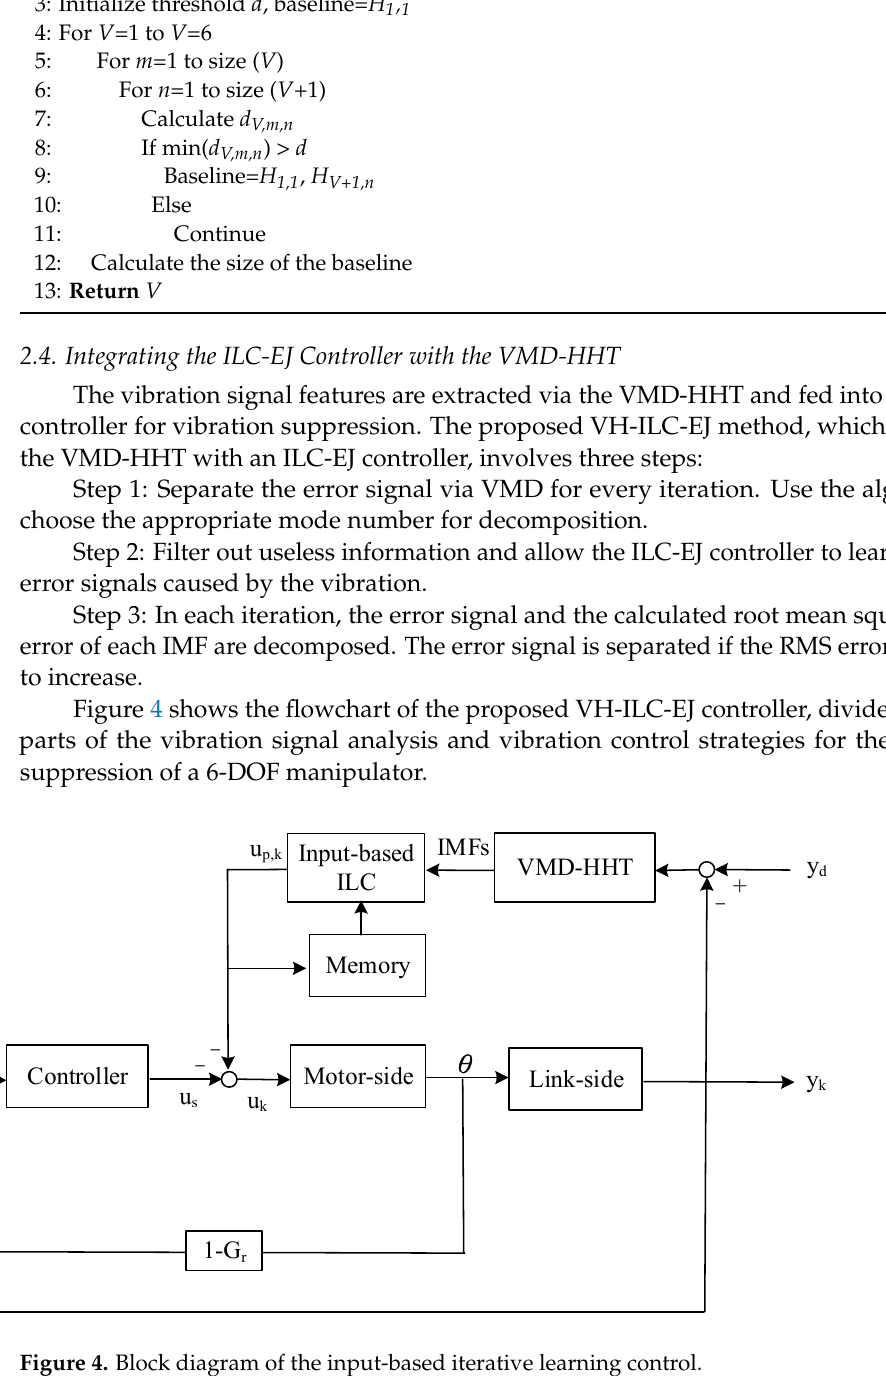
Table 2. Dynamic parameters of the 6-DOF robotic arm.